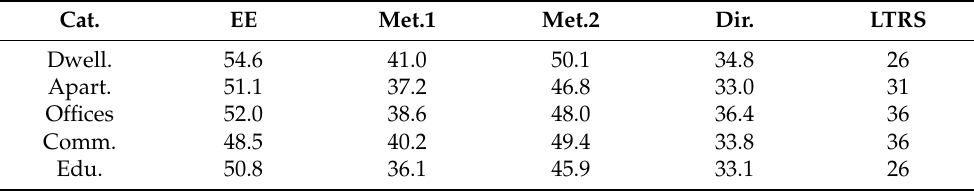
Table 16. CO 2 (%) reduction in 2033 according to EPBD and LTRS vs. 2020. Cat. EE Met.1 Met.2 Dir. Dwell. 54.6 Apart. Offices